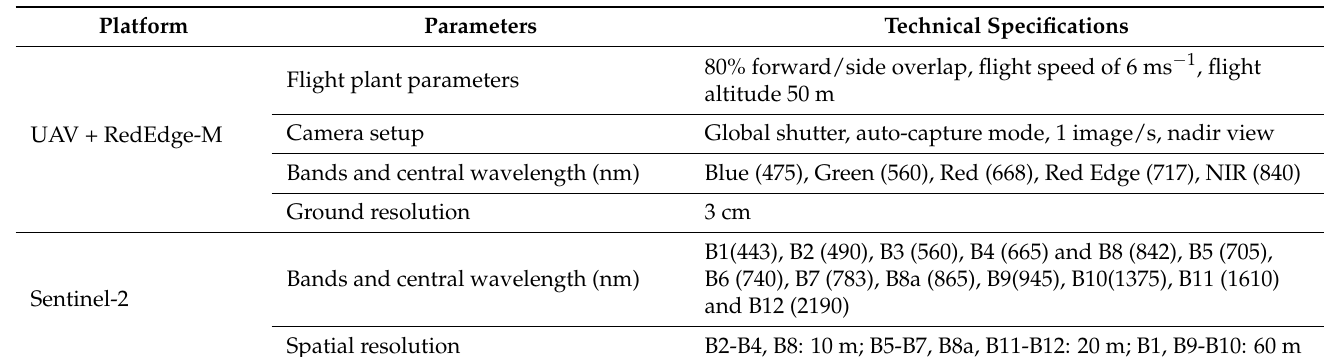
Figure 3. The actual flight route of UAV for the barley field. Table 1. Summary of UAV multispectral camera and flight campaign technical specification and Sentinel-2 image